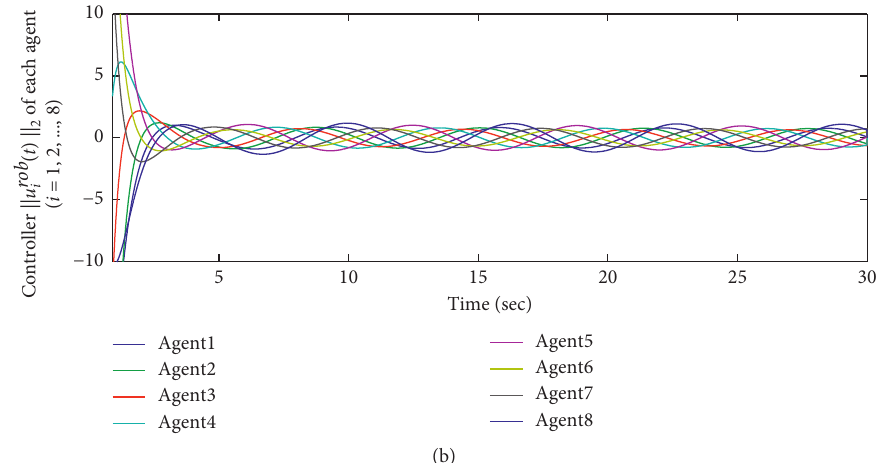
Figure 6: Input signal of eight